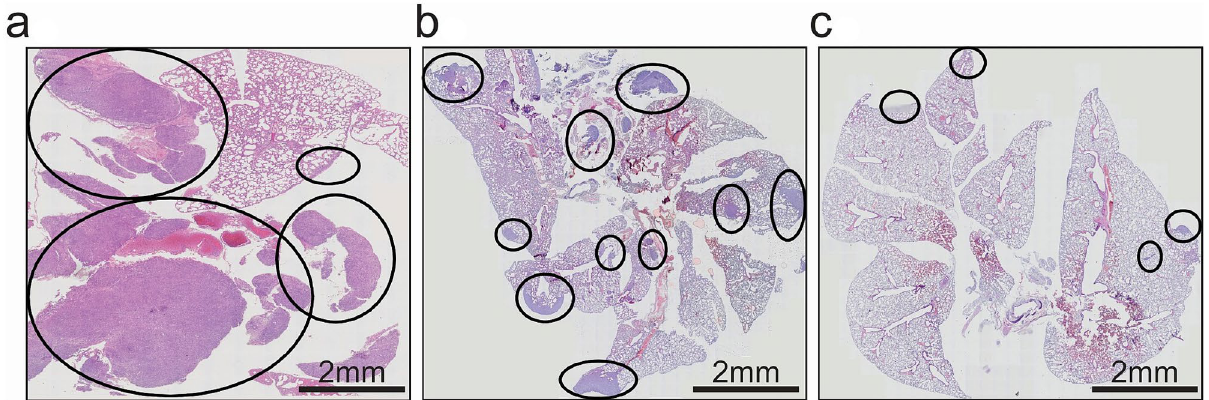
Figure 5. Microscopic aspects of lung metastasis. a . untreated b . treated 10% CD-NHF; c . treated 20% CD-NHF. Pictures acquired at